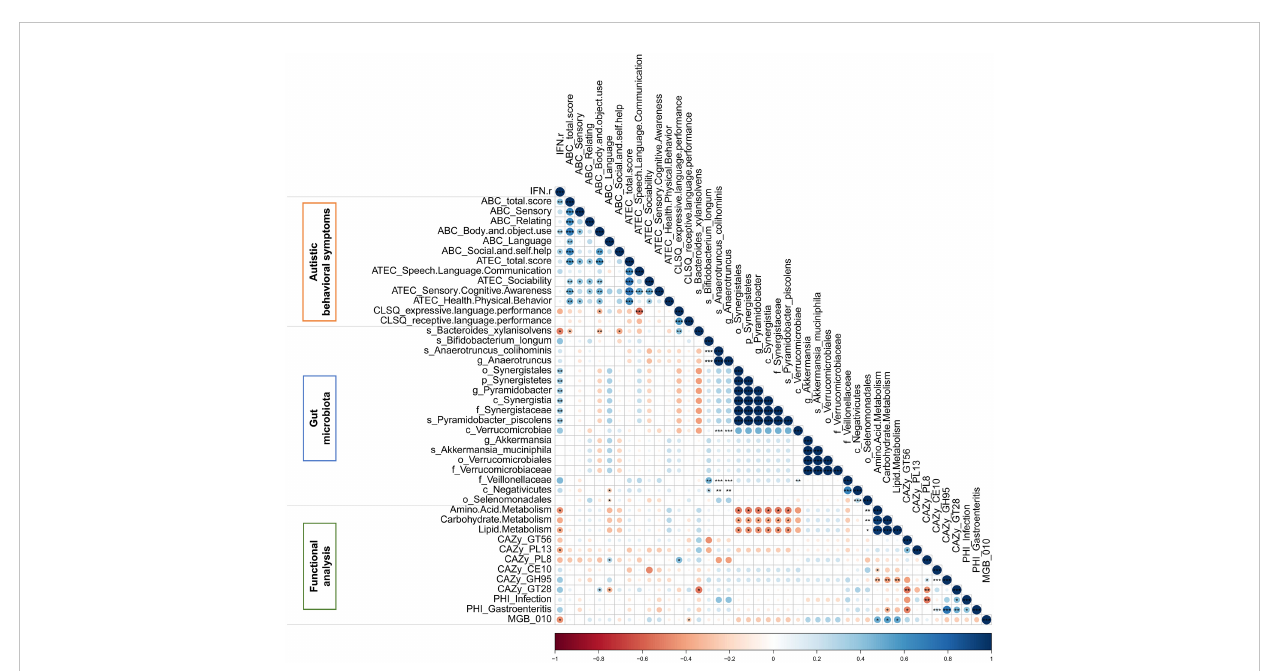
FIGURE 7 The Spearman correlation matrix among IFN- g , autistic behavioral symptoms, gut microbiota and functional modules which were signi fi cant in autistic children. Color intensity re fl ects Spearman correlation coef fi cient. * p <0.05, ** p <0.01, *** p